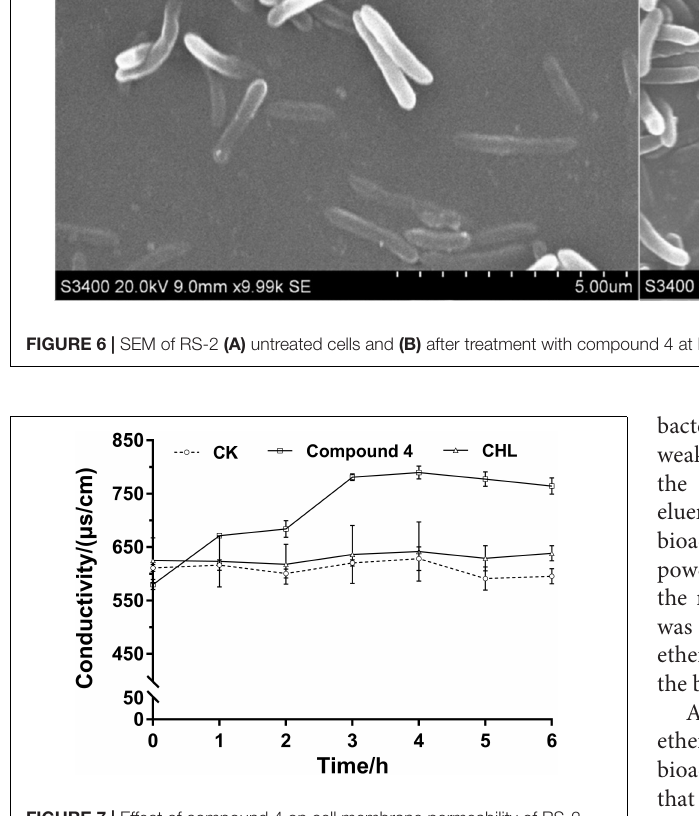
FIGURE 7 | Effect of compound 4 on cell membrane permeability of